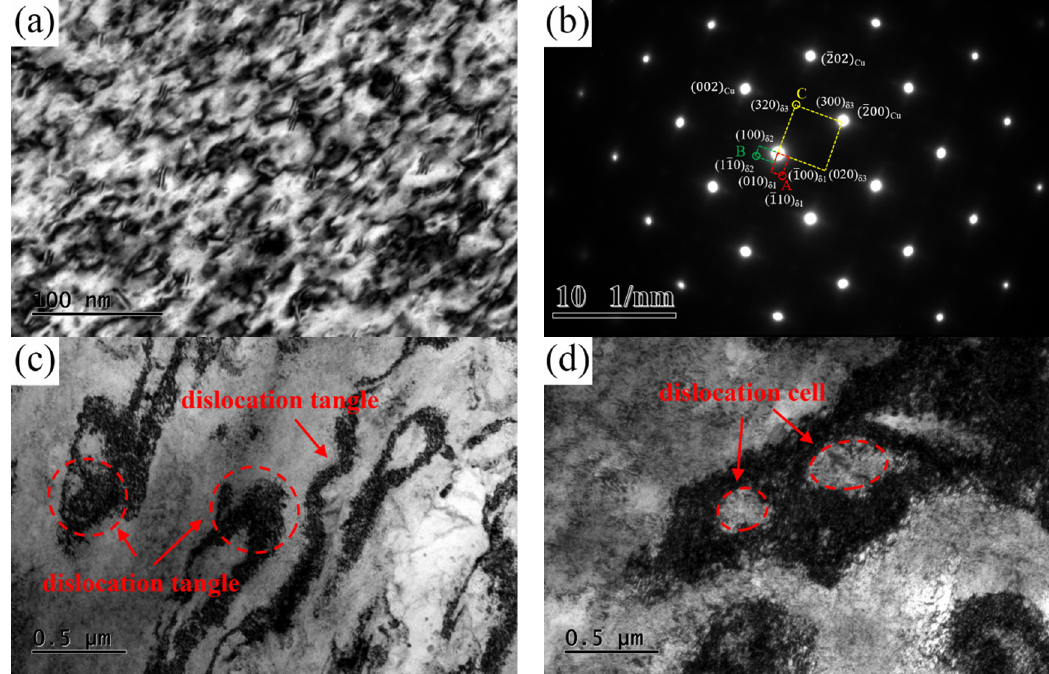
Figure 12. TEM images of the NS ‐ 4 alloy with heat treatment of TP ‐ c. ( a ) Bright ‐ field TEM image along [110] Cu , ( b ) SAED image corresponding of [001] Cu , ( c ) dislocation tangles, and ( d ) dislocation cells.